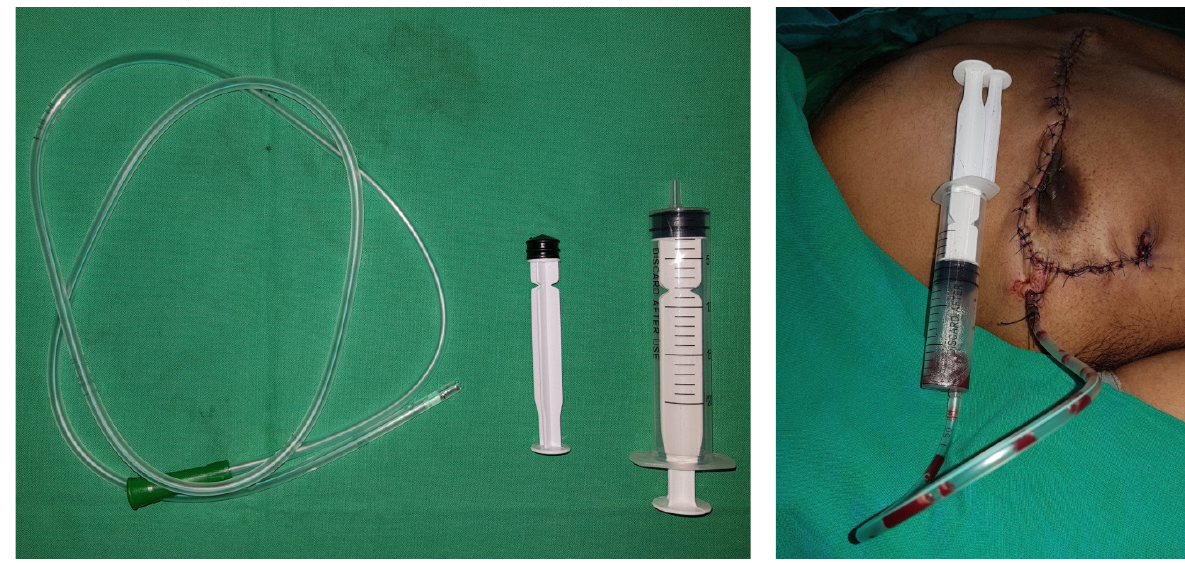
Figure 1: Negative pressure drain assembled with Ryle’s tube and